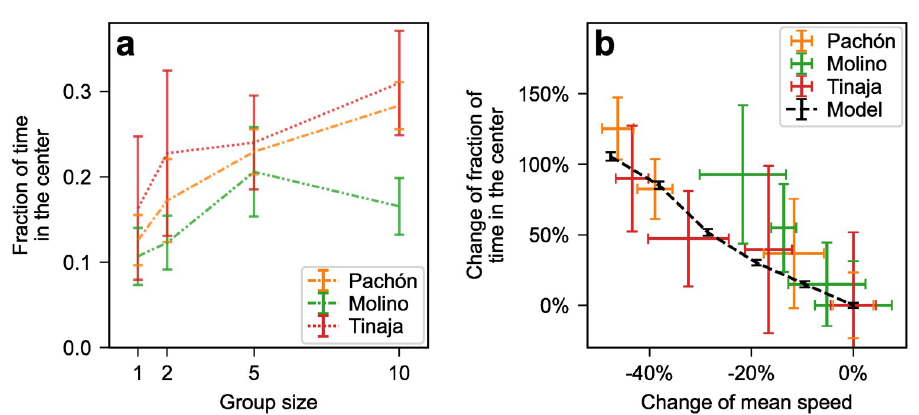
Fig 7. (a) Fraction of time spent in the inner half of the tank (within 39.2 cm of its center, which represents half of its area) as a function of group size in cave populations. (b) Percentage increase of the fraction in the center as a function of the percentage increase of the mean swimming speed in cave populations. Each colored cross represents the average of a specific population and group size. Increase percentages are computed using the isolated-fish mean as reference. This is done independently for each population. As a result, all three isolated-fish crosses (one for each population) are located at (0%, 0%). The black dashed curve shows the results of the computational